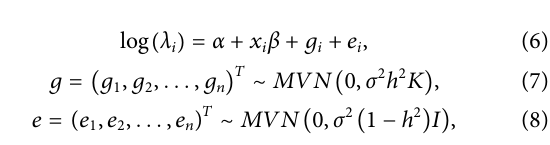
Frontiers in Genetics |